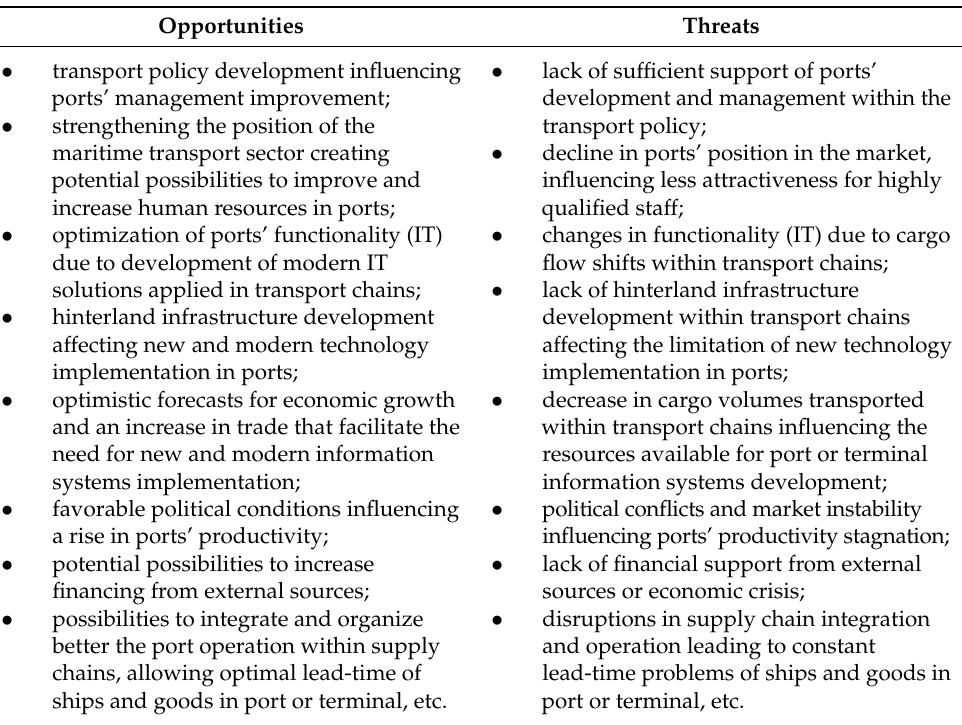
Table 1. Cont. Opportunities